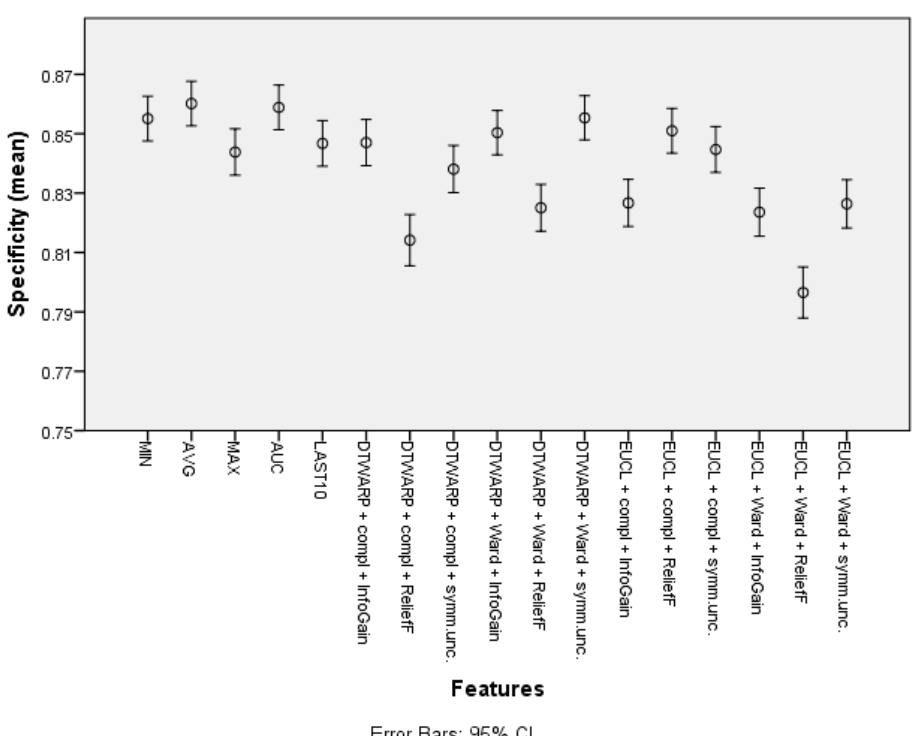
Figure 6. Sensitivity of Naïve Bayes classifiers: mean values and 95% confidence intervals.